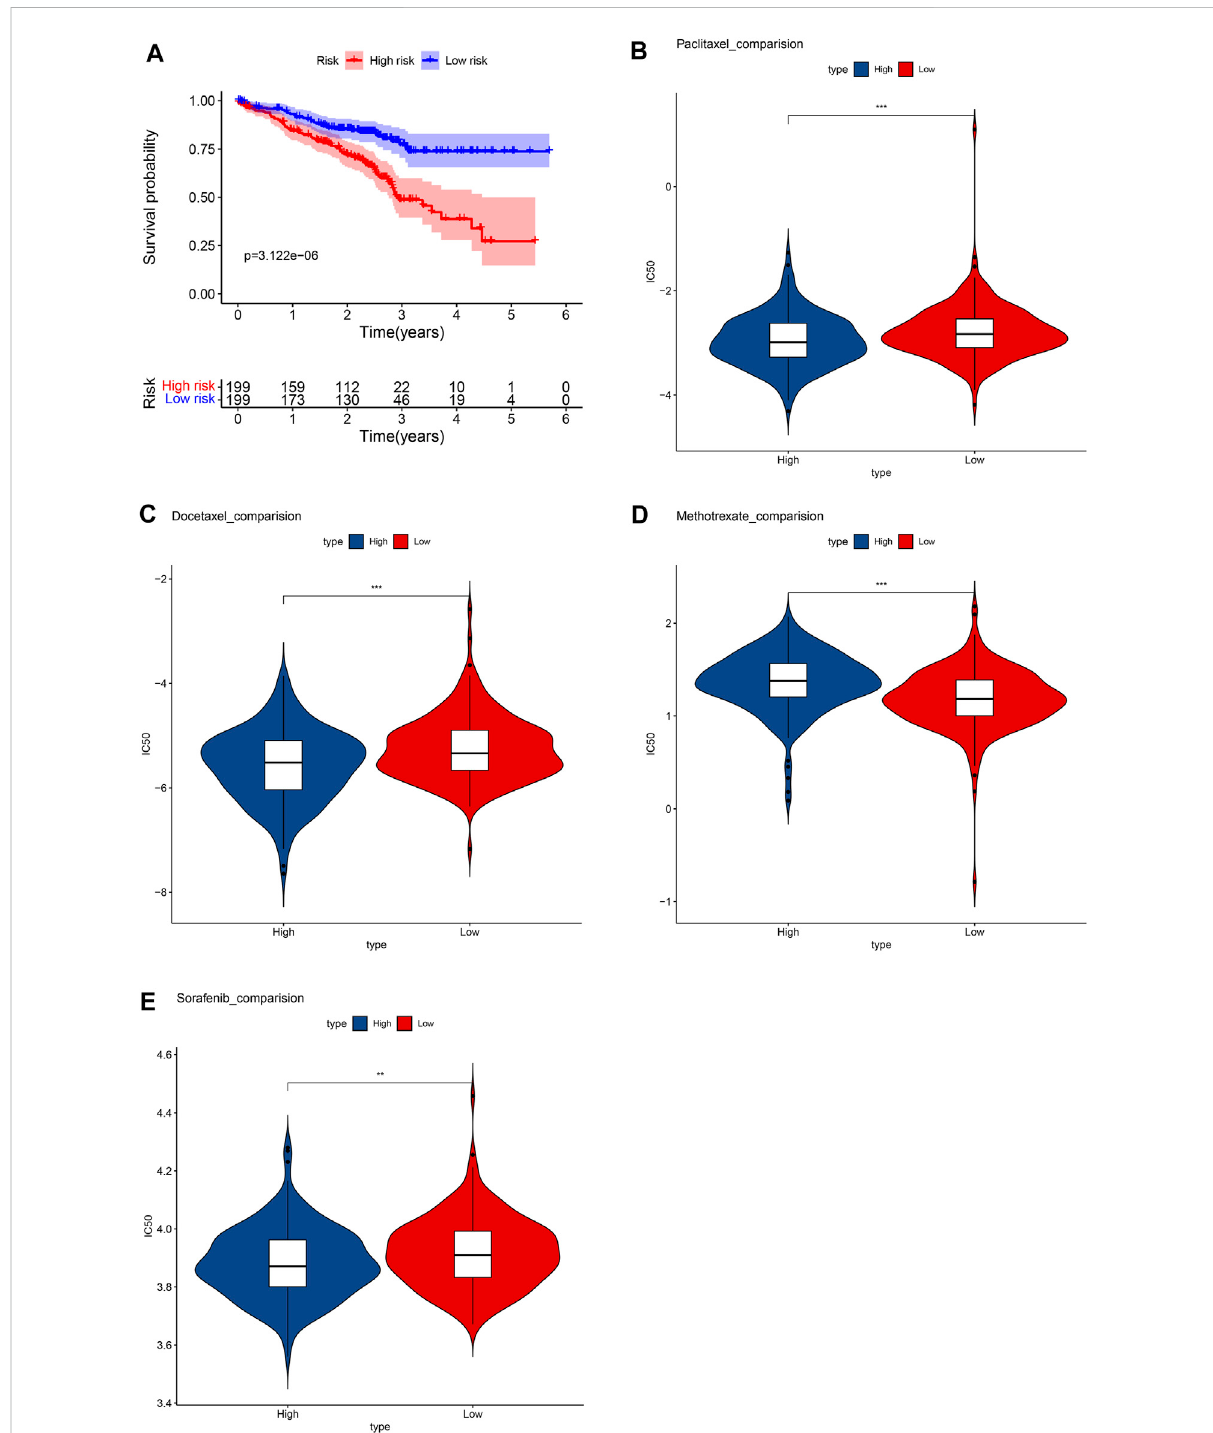
FIGURE 8 Verify the results in the GEO database. (A) Survival analysis between high- and low-risk groups. Box plots depicted the differences in the estimated IC50 levels of (B) Paclitaxel; (C) Docetaxel; (D) Methotrexate; (E) and Sorafenib between the high- and low-risk